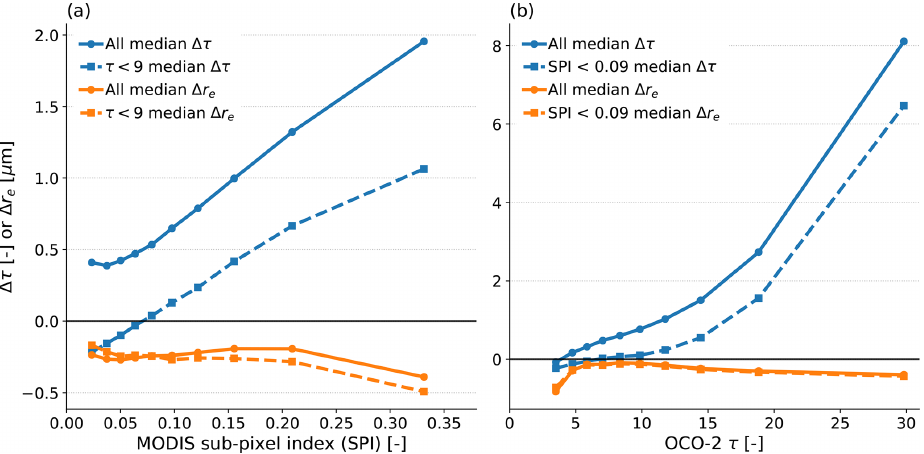
Figure 6. Binned median bias in OCO-2 minus MODIS τ (blue) or r e (orange) when (a) binned by the MODIS sub-pixel index (SPI) derived from the 250m sampling at λ = 0 . 66µm or (b) binned by the OCO-2 LUT retrieved τ . Solid lines are for the full samples, and dashed lines are for the subset (a) below the median OCO-2 τ or (b) below the median MODIS SPI.